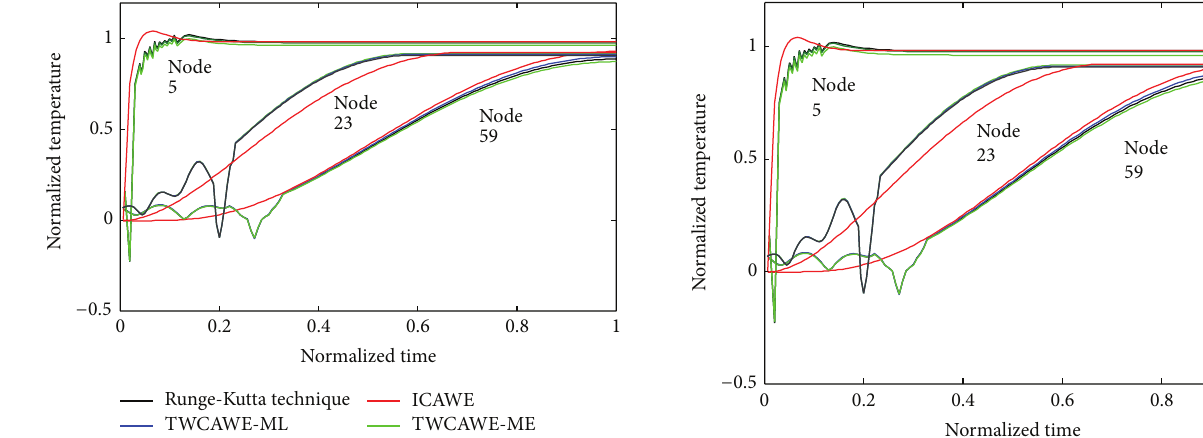
Figure 6: Comparison of TWCAWE-ML, TWCAWE-ME, Runge- Kutta technique, and ICAWE for the case of 𝑍 𝑇 = 0.0001 .